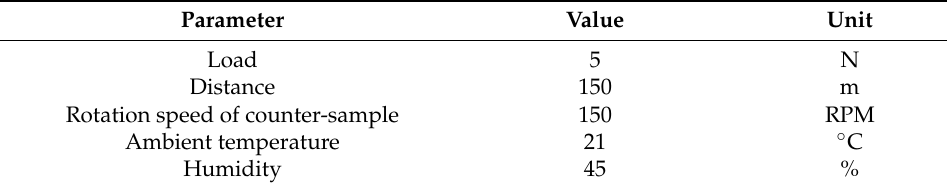
Figure 4. Dependence of the η parameter on: ( a ) load P , ( b ) friction distance S , and ( c ) counter-rotational speed n .